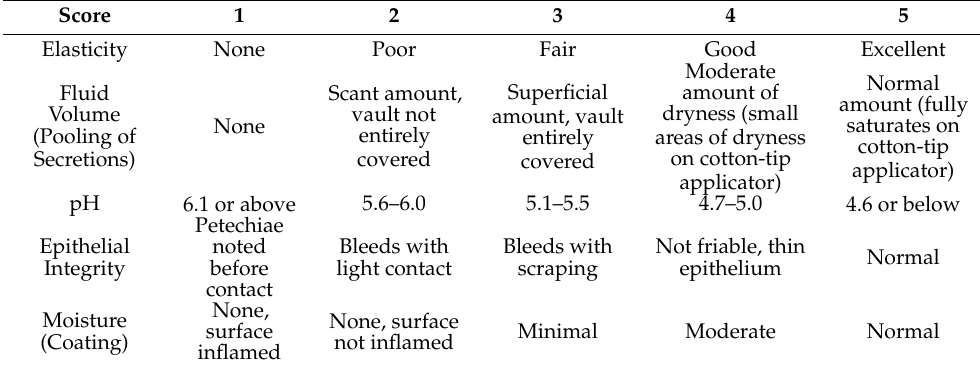
Table 1. The vaginal health index (VHI) (adapted from Bachmann et al. [20]).